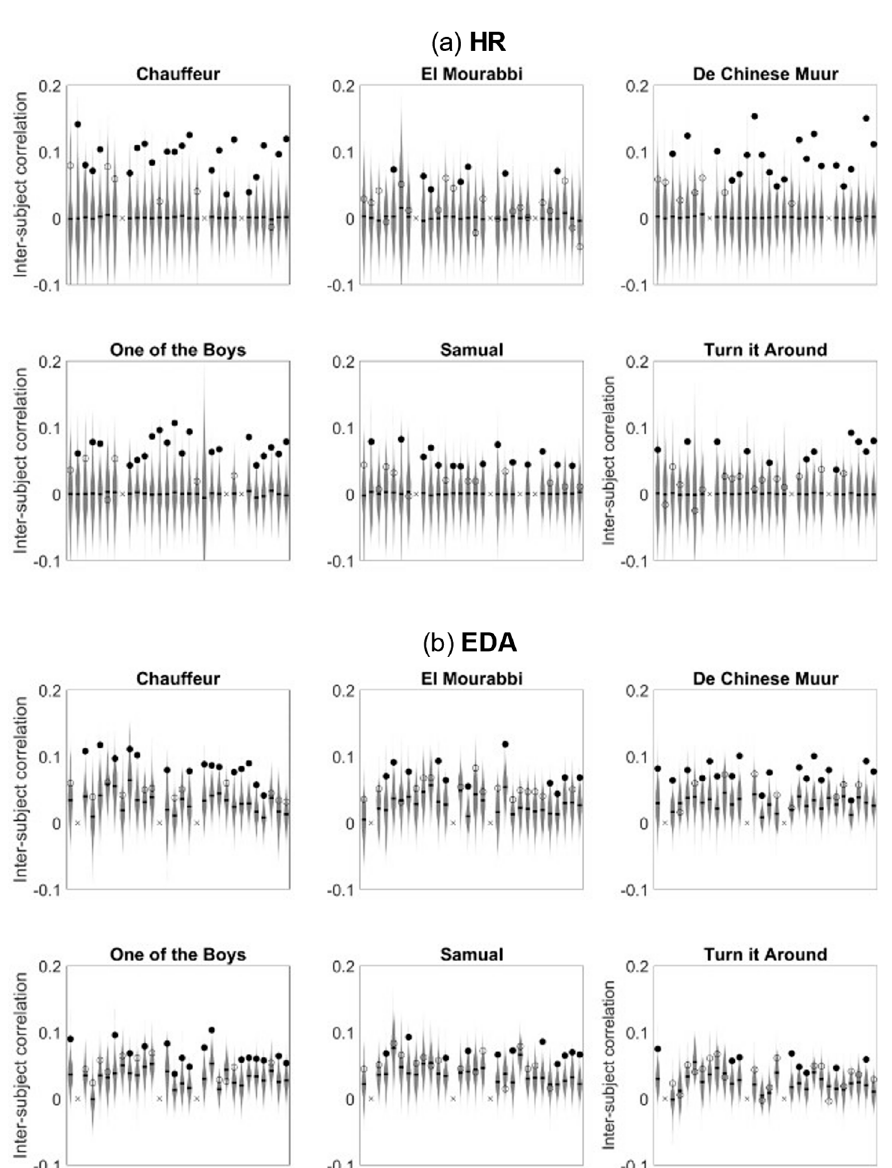
Figure 1. Participant-to-group physiological synchrony for each participant’s HR ( a ) and EDA ( b ). In each window, each marker refers to a participant. Filled markers depict inter-subject correlations exceeding chance-level correlations based on 500 trials of circular shuffle (depicted by the grey distributions); open markers depict inter-subject correlations not exceeding chance level. x depicts missing data.